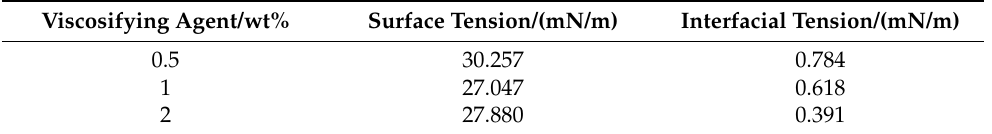
Table 6. Surface/interfacial tensions. Viscosifying